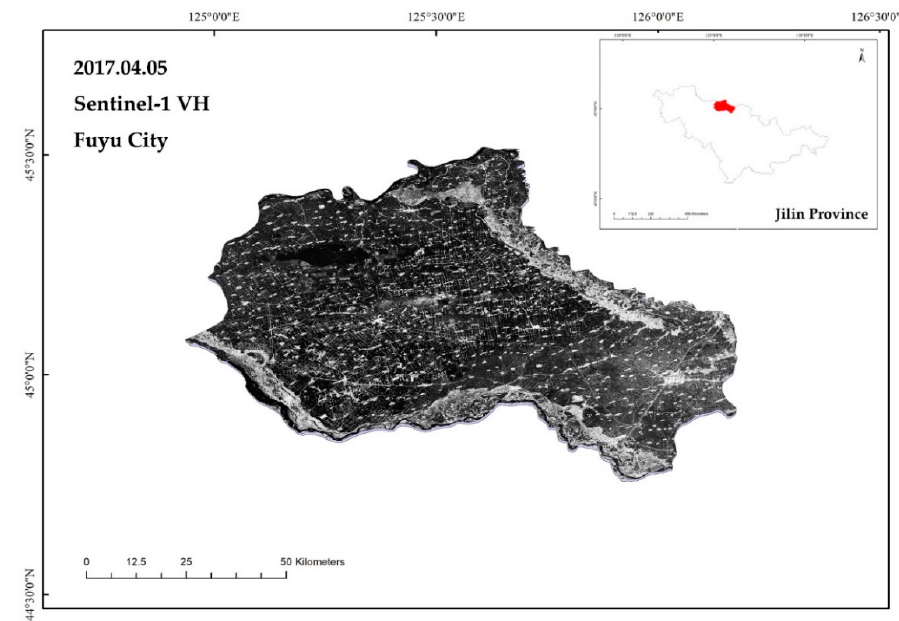
Figure 3. Study region: Fuyu City, Jilin Province, China.